Question: Sum up the contents of this chart in one sentence.
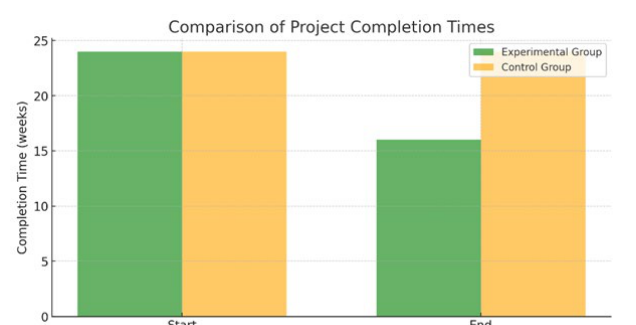
Answer: Comparison of Project Completion Times